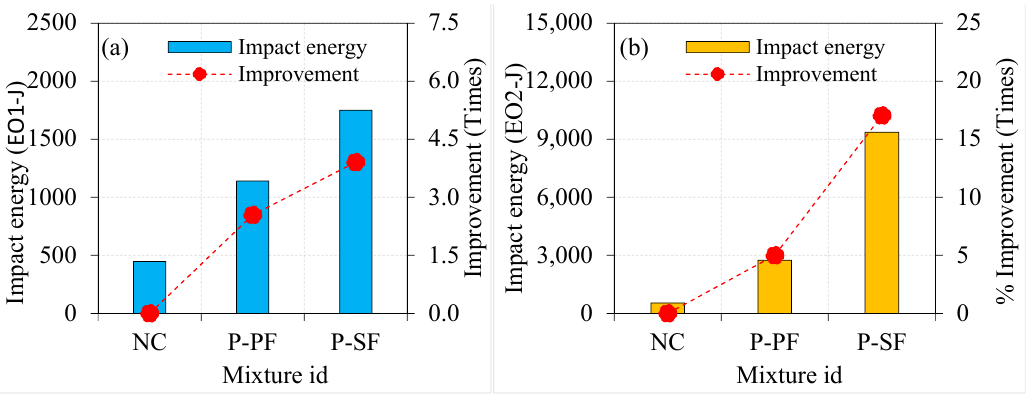
Figure 13. Effect of fibres on natural aggregate specimens ( a ) EO1 and ( b ) EO2.